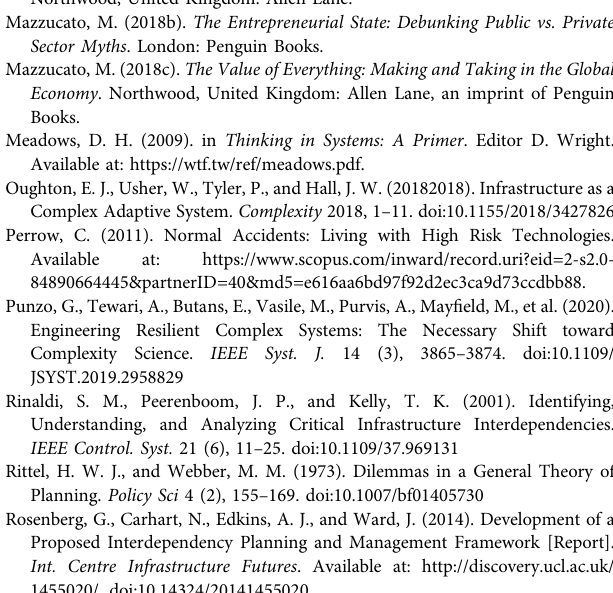
Figueres, C., and Rivett-Carnac, T. (2020). Future We Choose: Surviving the Climate Crisis. Available at: https://www.overdrive.com/search?q (cid:1) 17CC75C1- 48DB-411E-967E-DD0C86CEE0EB. Fong, W. K., Sotos, M., Doust, M., Schultz, S., Marques, A., and